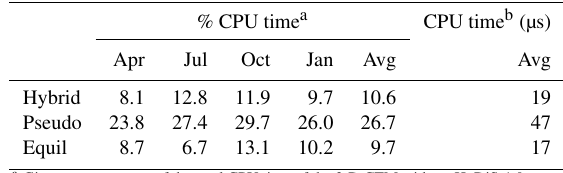
Table 5. 3-D CTM computation time requirements of